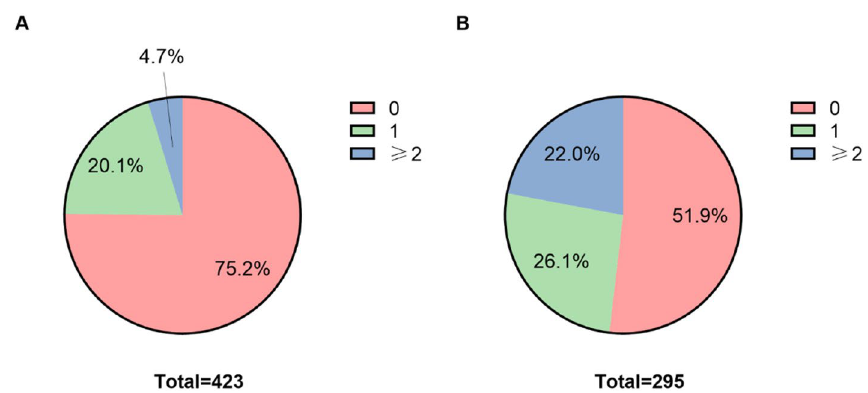
Figure 2. Distribution of the comprehensive index in healthy individuals and gastric cancer